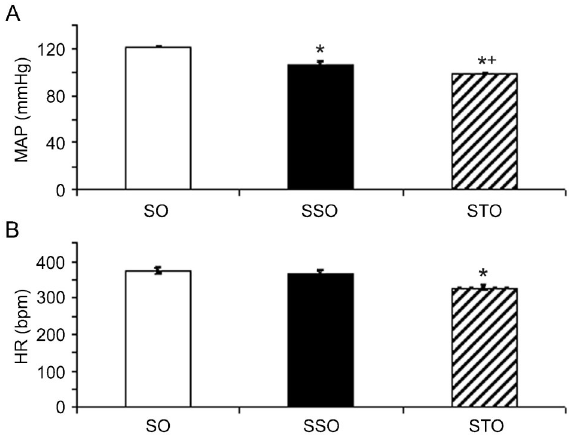
Figure 1. Mean arterial pressure (MAP; A ) and heart rate (HR; B ) of sedentary ovariectomized rats (SO), sedentary ovariectomized rats treated with simvastatin (SSO), and trained ovariectomized rats treated with simvastatin (STO). *P , 0.05 vs SO group; + P , 0.05 vs SSO group (one-way ANOVA followed by the Student- Newman-Keuls